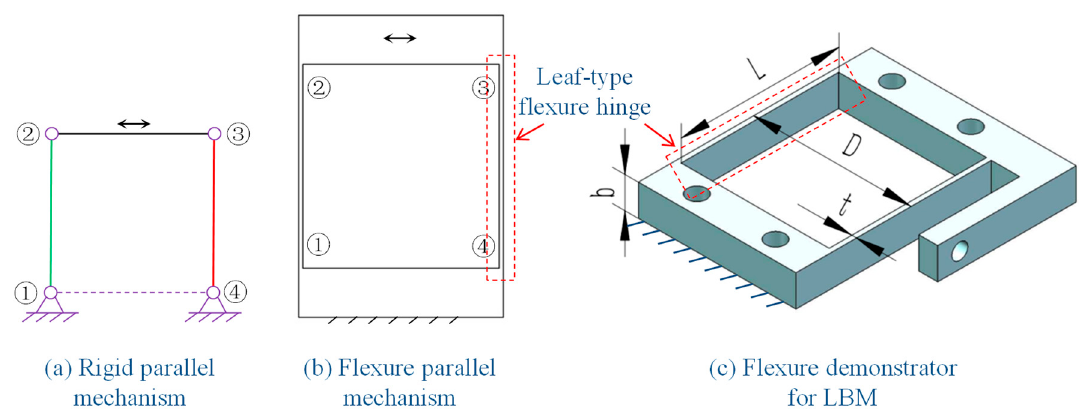
Figure 1. ( a ) Illustration of the equivalent rigid parallel mechanism for (( b ) top view) the flexure parallel mechanism and ( c ) the 3D model of the flexure demonstrator for laser beam melting (LBM) with the key dimensional parameters denoted as: the length of the flexure hinges L , the thickness of the flexure hinges t , the width of the flexure hinges b , and the distance between the flexure hinges D.